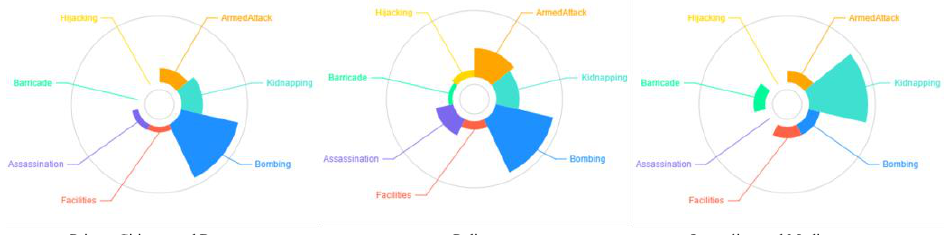
Figure 12 Type and extent of threat of different